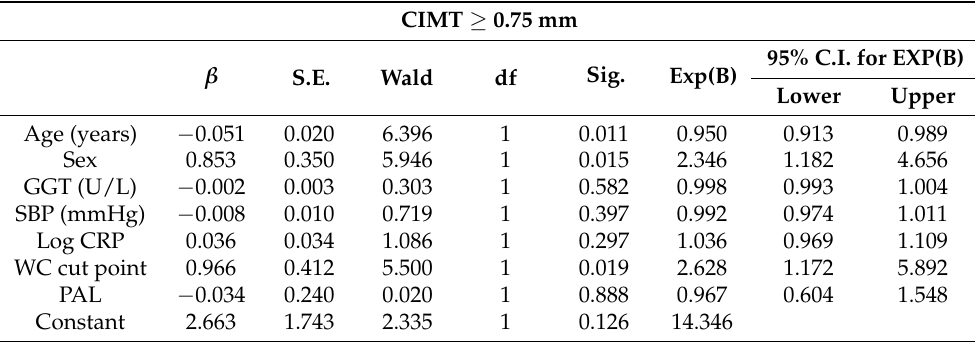
Table 5. Logistic regression analysis to assess the probability of central adiposity to predict subclinical atherosclerosis in a teachers’